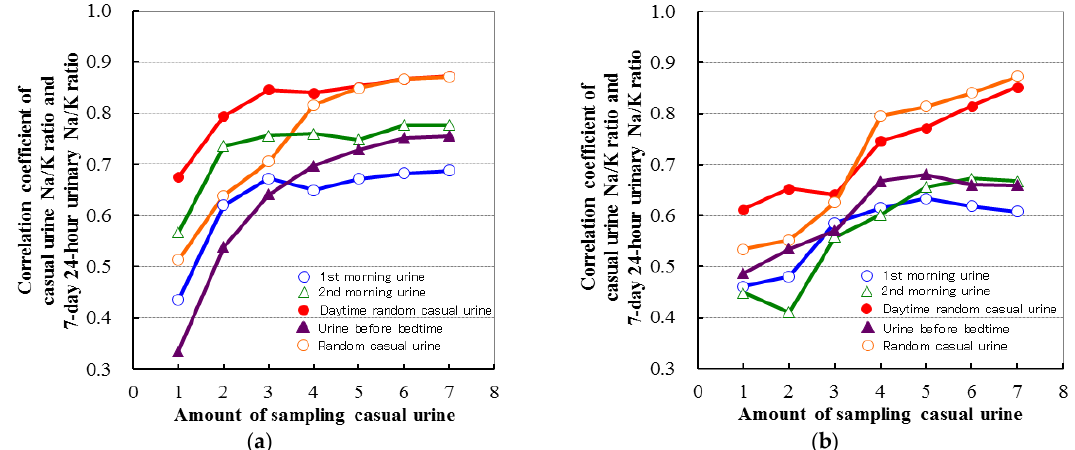
Figure 1. Correlation specification between numbers of repeated casual urine sampling and 7-day 24-h urine of sodium-to-potassium (Na/K) ratio in normotensive and hypertensive individuals (made from data of [67,68]). ( a ) Normotensive individuals; ( b ) Hypertensive individuals.